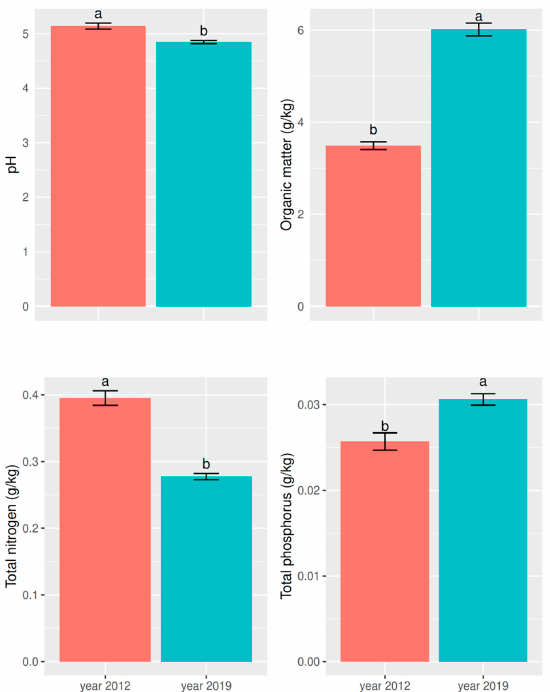
Figure 1. Bar plot showing soil pH values and organic matter, total nitrogen, and total phosphorus concentrations in 2012 and 2019. Error bars are the standard errors. Different letters indicate significant differences between the investigation years according to Wilcoxon’s rank test ( p < 0.05). The Shannon–Wiener index (W = 6100.0, p = 0.01 ) , Simpson index (W = 5907.0, p = 0.01 ) and species richness (W = 6462.5, p = 0.00 ) were significantly higher in 2012 than in